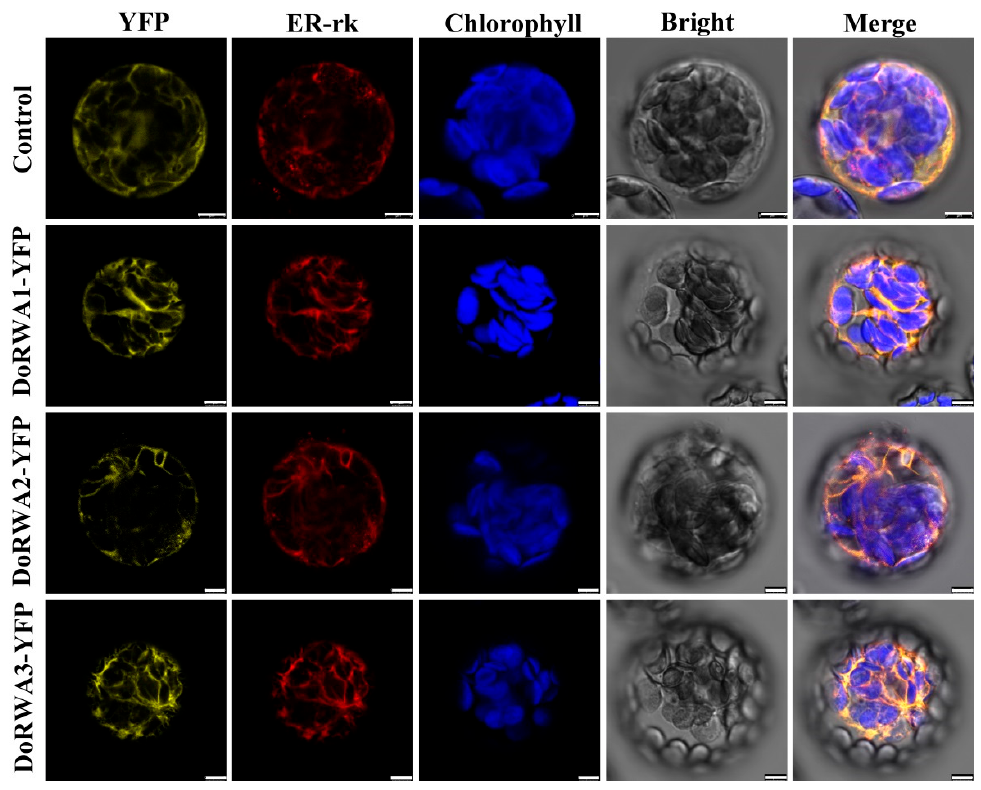
Figure 4. Subcellular localization of YFP, DoRWA1-YFP, DoRWA2-YFP and DoRWA3-YFP with the endoplasmic reticulum localization marker ER-rk in the Arabidopsis thaliana mesophyll protoplasts. Bar = 5 μ m.